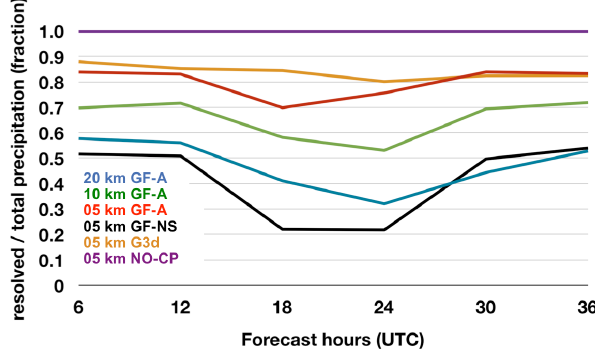
Figure 7: Fraction of resolved precipitation compared to total precipitation. 6-hourly precipitation rates are averaged for each experiment over the 15 runs and over the domain and displayed as a diurnal profile. Figure 7. Fraction of resolved precipitation compared to total pre- cipitation. 6-hourly precipitation rates are averaged for each experi- Next we compare averages over the areas shown as red boxes in Figure 8 and at ment over the 15 runs and over the domain and displayed as a diur- 1800UTC, 8 January 2013. First, Figure 9 compares convective heating and drying nal profile. profiles with varying assumptions and horizontal resolutions. The boxes were chosen focusing on areas that are characteristic of different convective regions over or nearby South America: the ITCZ over the equatorial Atlantic Ocean; an area over north-central Brazil associated with daytime surface forcing and one over southern Brazil associated with a mid-latitude cold front approach. Increasing the resolution from 20 to 5 km, the magnitude of the convective heating and drying rates decreases almost monotonically reducing the impact of convective parameterization on the model grid scale. Without Arakawa’s adjustment factor, the convective heating and drying rates are much higher for GF-NS on 5km horizontal resolution compared to 20km resolution, a result probably